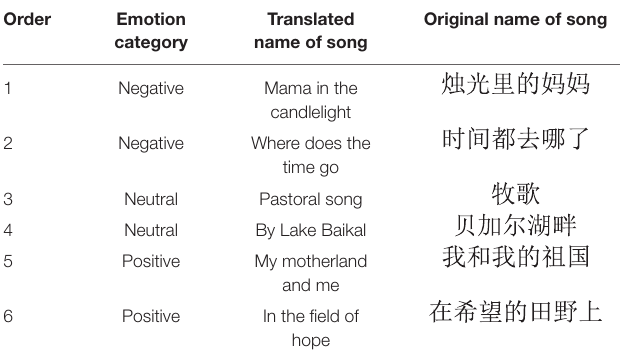
TABLE 1 | Emotional stimulation